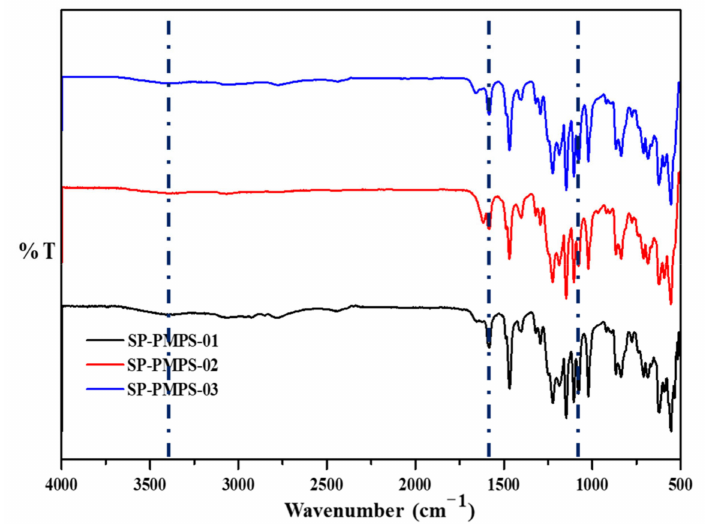
Figure 1. Fourier-transform infrared spectroscopy (FT-IR) spectra of synthesized sulfonated poly (1,4-phenylene ether-ether-sulfone)-poly (2-Acrylamido-2-methyl-1-propanesulfonic acid) SP-PMPS